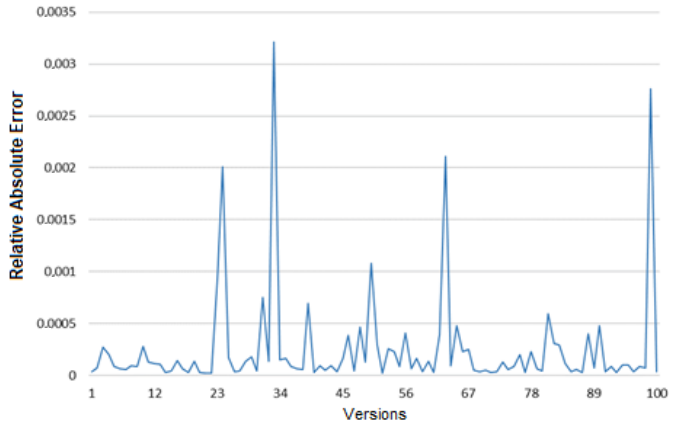
Figure 10. Estimated final DEC values.